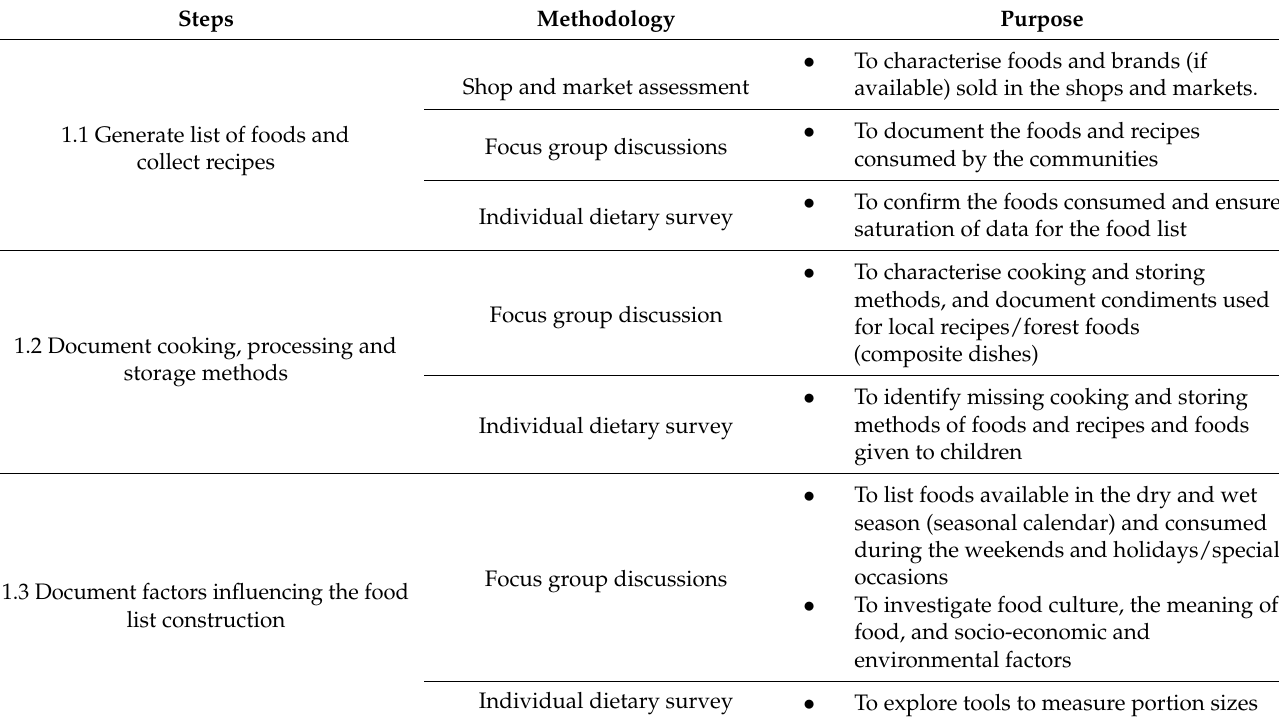
Table 1. Methods used for local, field-based sourcing of food and recipe